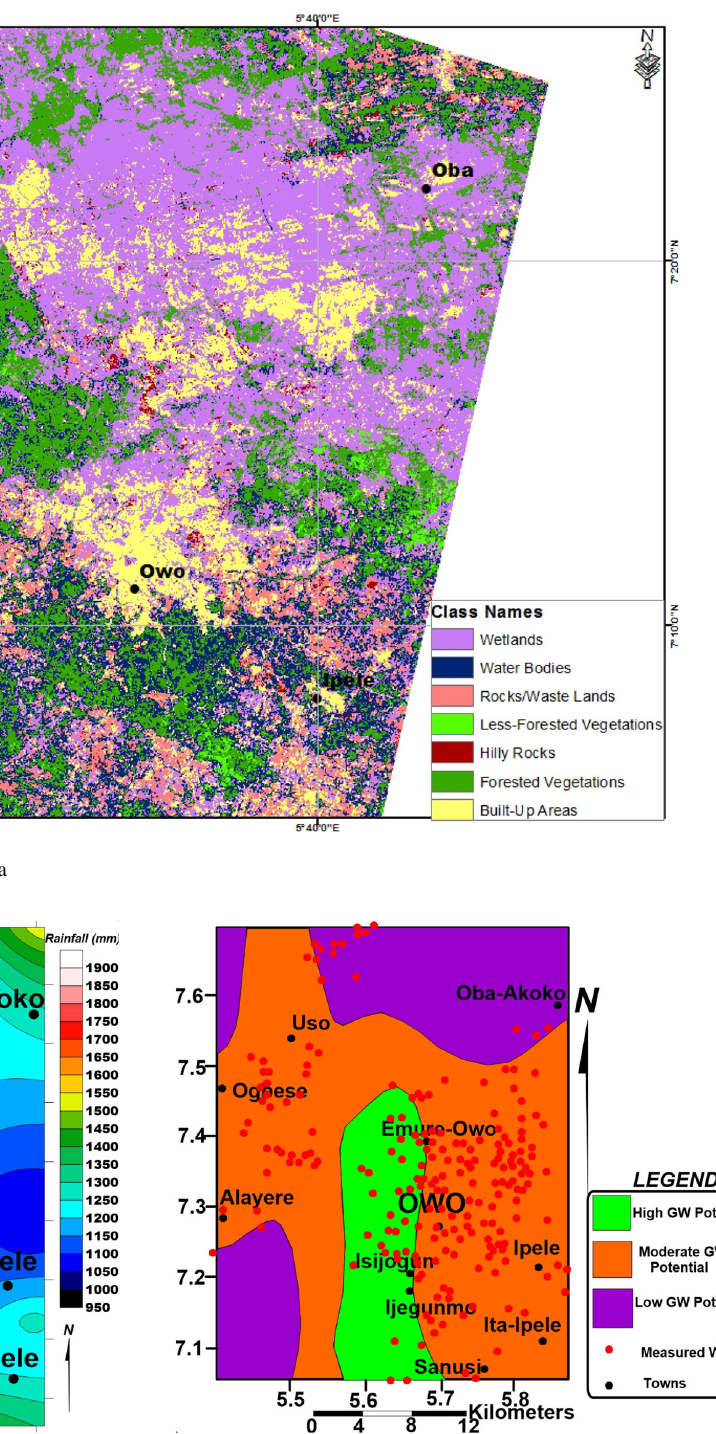
Fig. 10 Groundwater potential map of the study